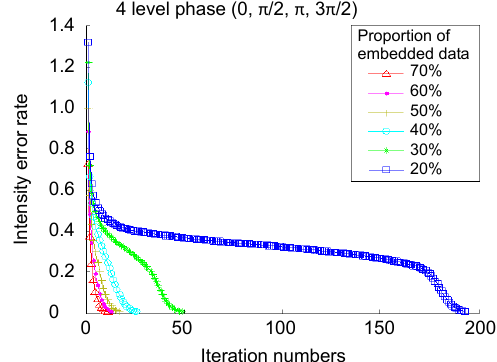
Fig. 10 | Convergent curves with different proportions of em- bedded phase